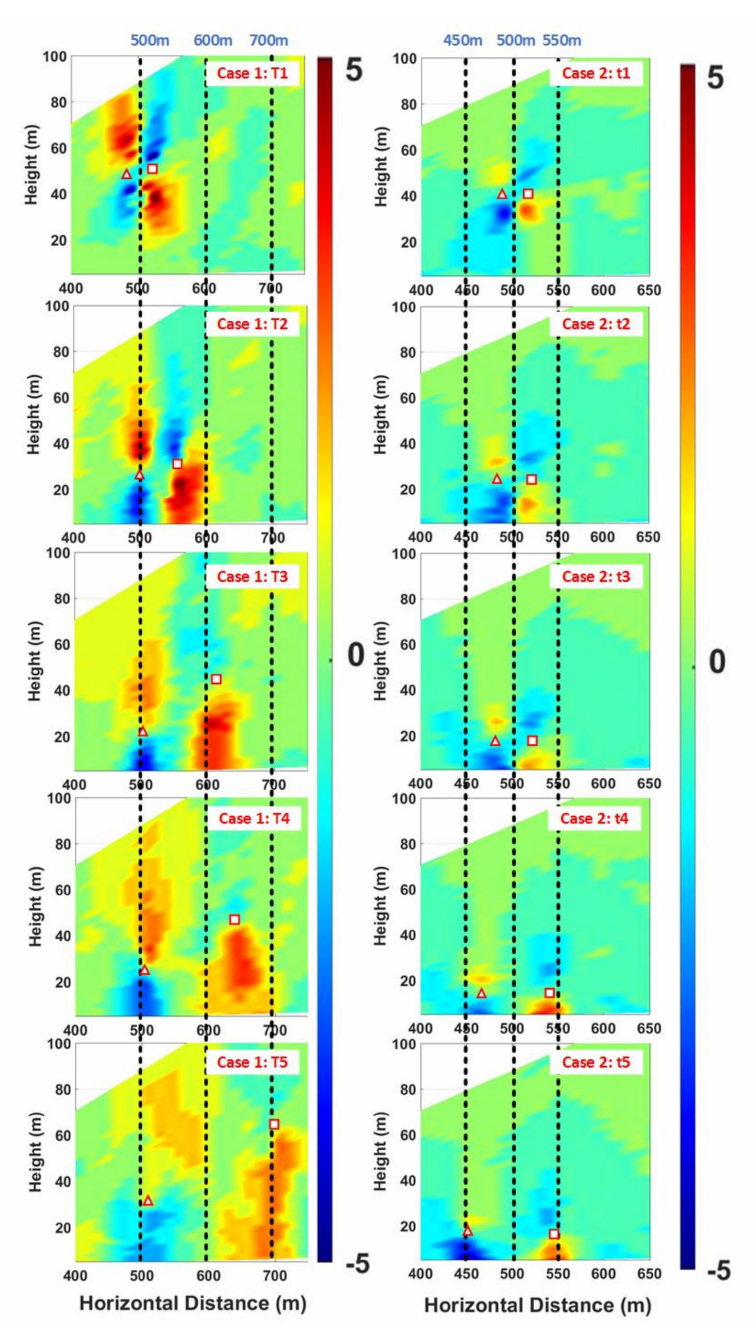
Figure 8. Evolution characteristics of the radial velocity distribution of wake vortex with crosswind (Case 1) and without crosswind (Case 2). The triangles and squares in the figure indicate the positions of the left and right vortex cores,